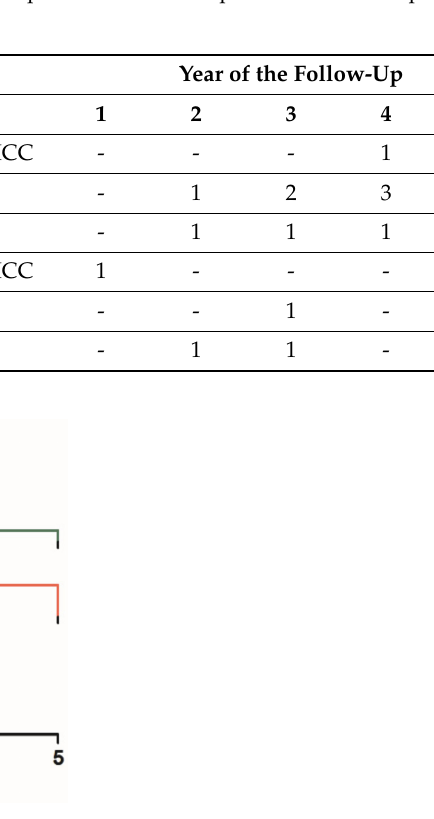
Figure 1. Kaplan–Meier plots of patients survival depending on presence of cirrhosis at the baseline.